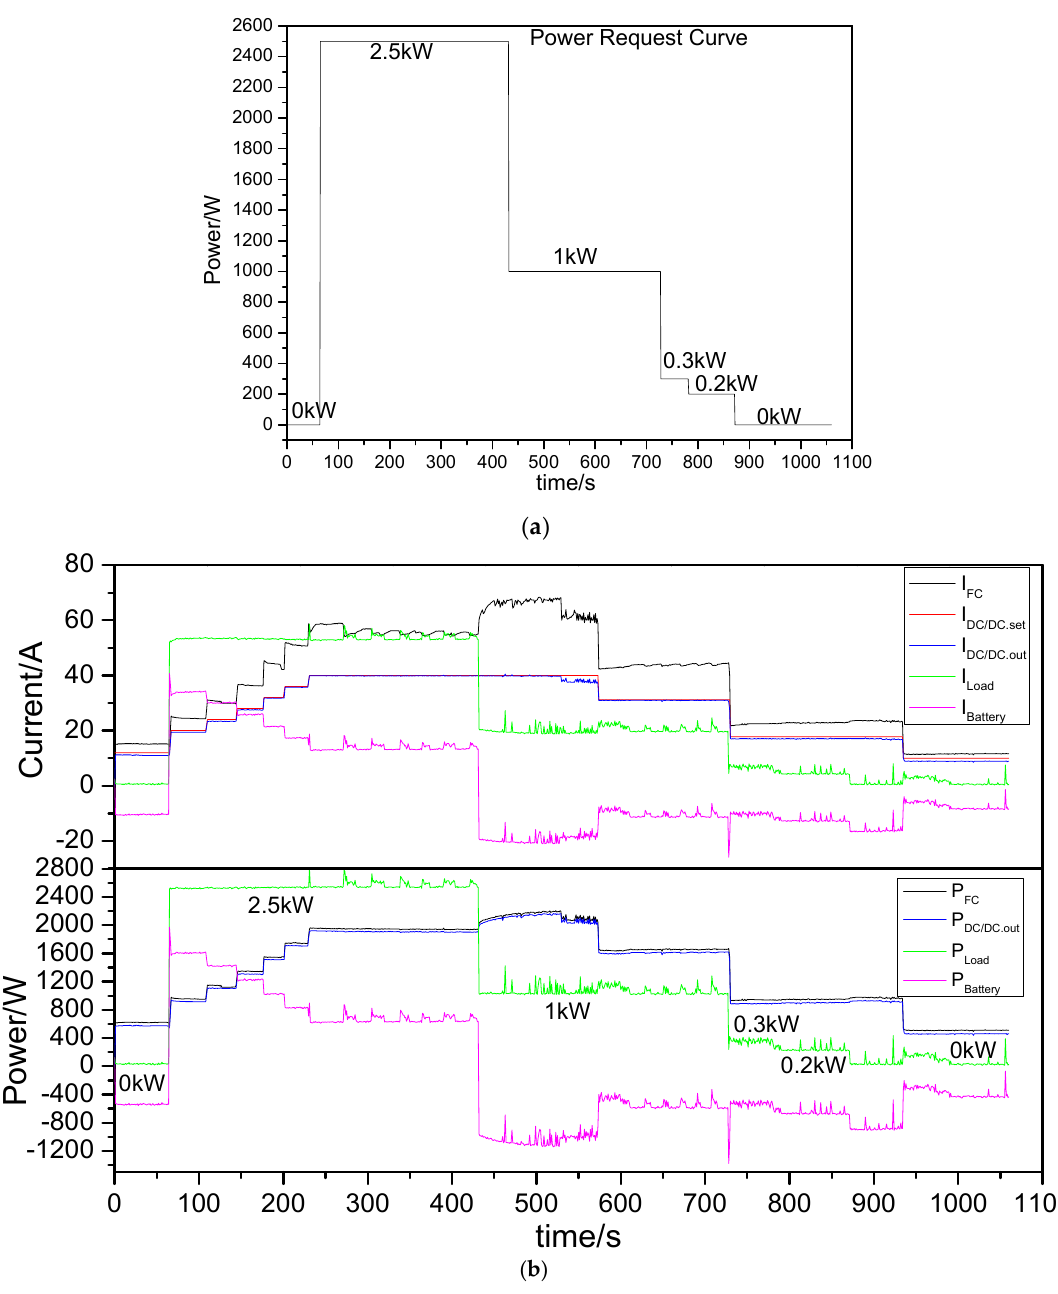
Figure 13. Response test when load power is slowly reduced. ( a ) Request curve of load power; and ( b ) the response curve of current and power.